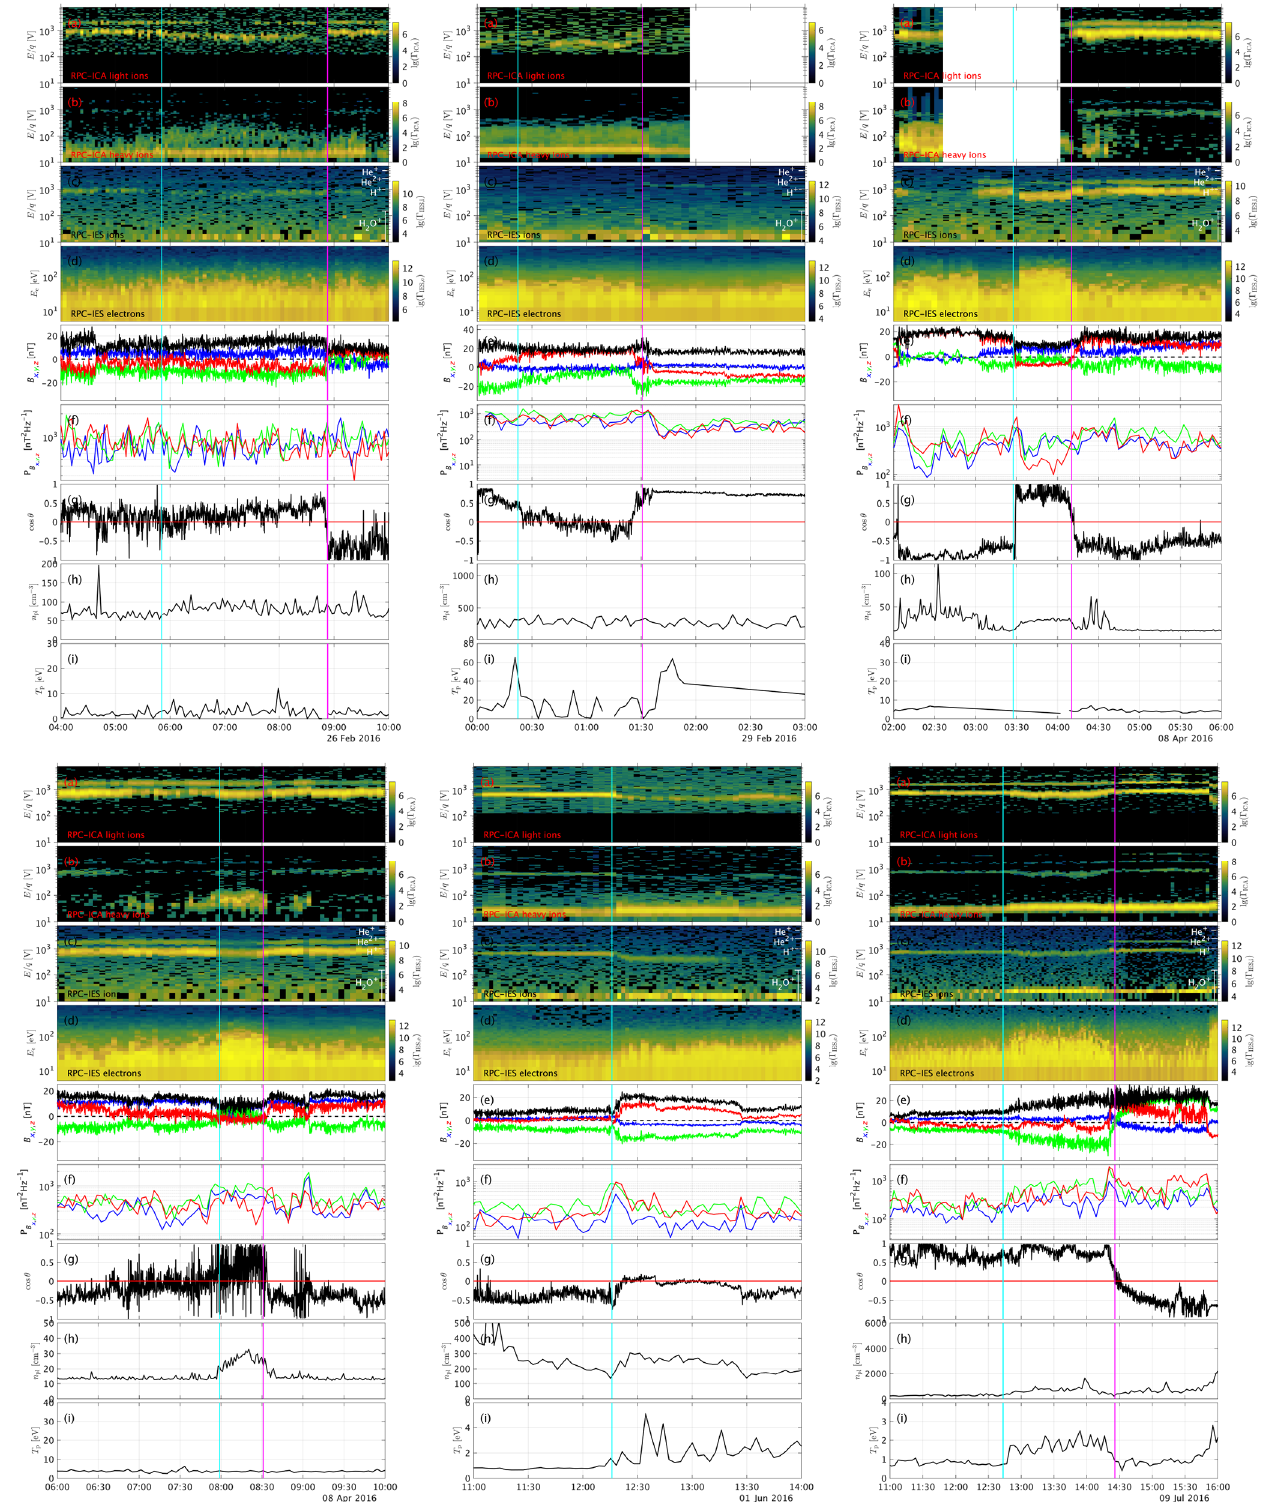
Figure A2. Observations of the plasma for the events shown in Table 1. The format is the same as in Fig.